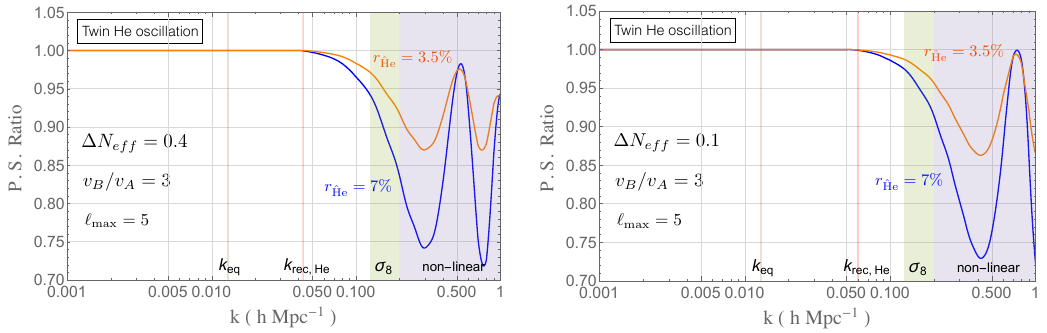
Figure 4 . Ratio of matter power spectrum between (cid:3)CDM+MTH and (cid:3)CDM+DR, including only twin helium oscillations. k rec ; He corresponds to the time of twin helium recombination as obtained from the Saha equation eq. (2.27).